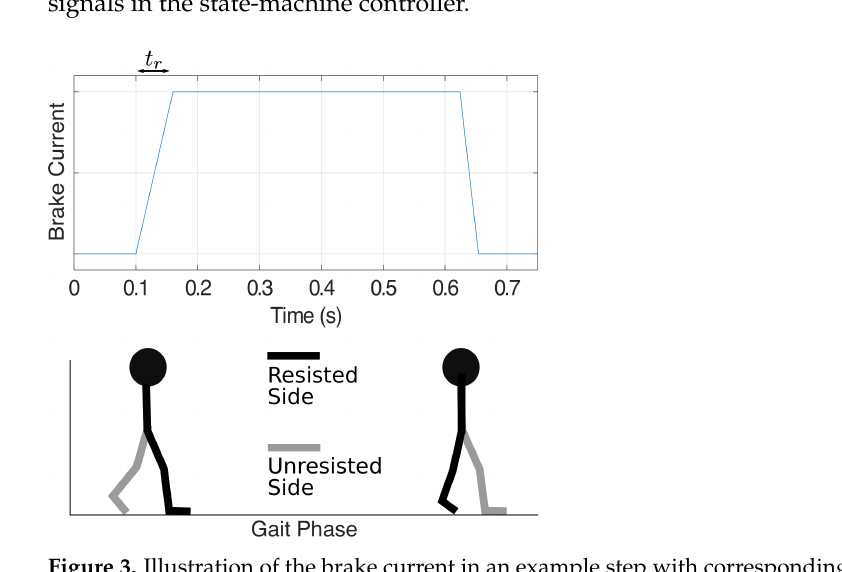
Figure 3. Illustration of the brake current in an example step with corresponding gait phases as the user walks, where t r represents the ramp-up time when the brake is first actuated.